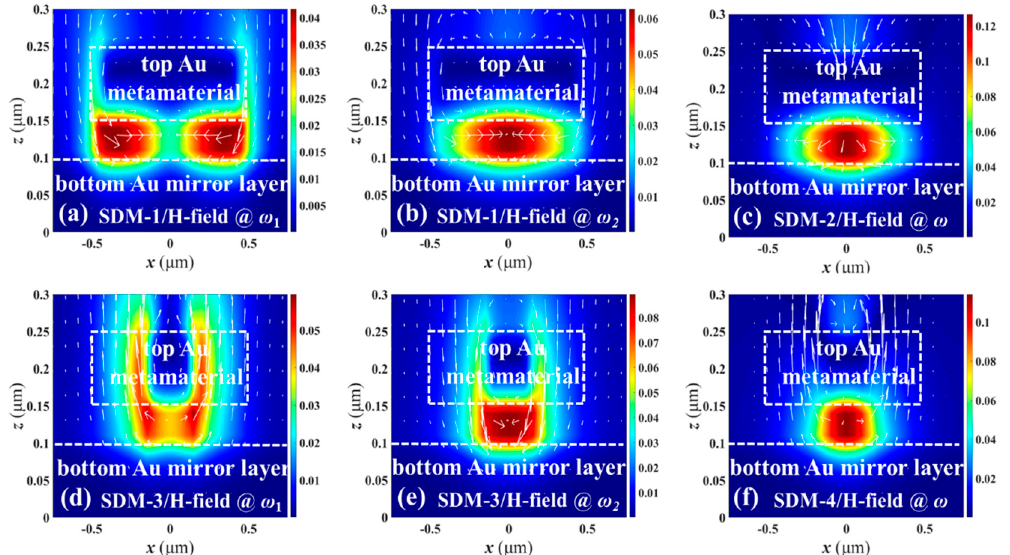
Figure 8. H-field distributions of SDM-1 monitored at ( a ) ω 1 and ( b ) ω 2 resonances, SDM-2 monitored at ( c ) ω resonance, SDM-3 monitored at ( d ) ω 1 and ( e ) ω 2 resonances, and SDM-4 monitored at ( f ) ω resonance, respectively.